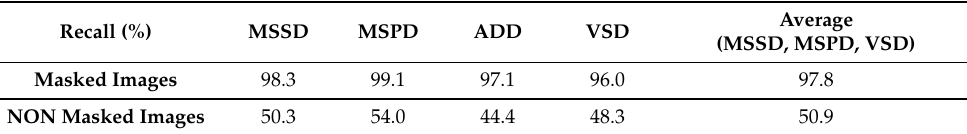
Figure 14. Examples of correct (row 1) and incorrect (row 2) predictions on non-masked validation images. The first column presents the input validation image, the second column the ground truth and the third one the estimated object pose. Table 1. Quantitative results for the evaluation of the object detection and localization model trained on laboratory data.